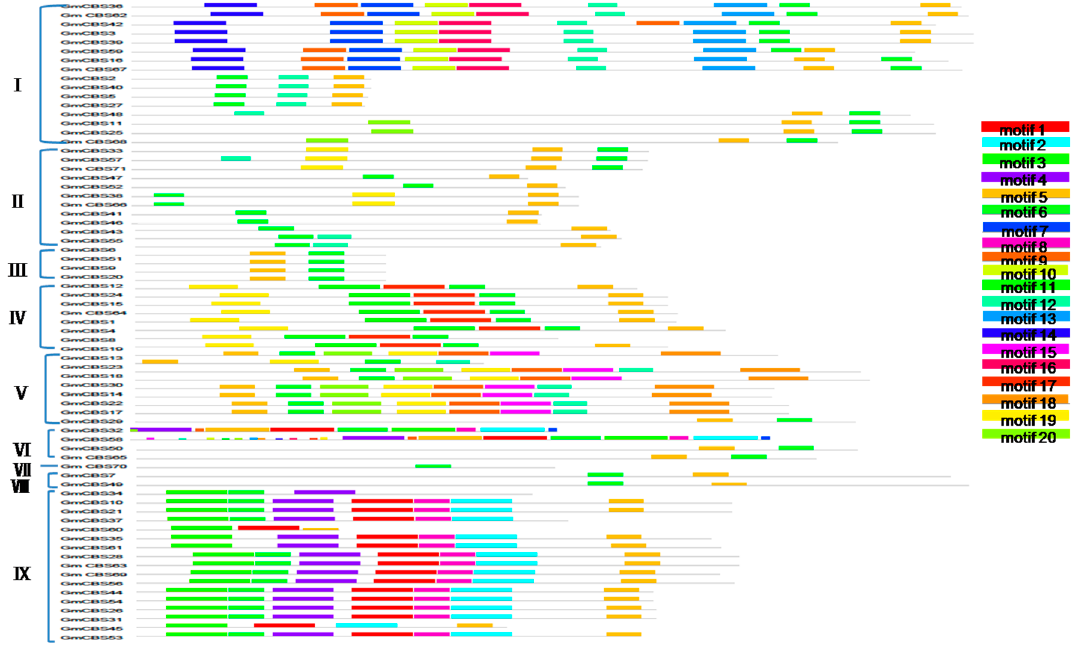
Figure 2. Schematic distribution of the conserved motifs in soybean CBS superfamily by MEME. The conserved motifs were identified in the proteins of every group. Each colored box below the tree represents the conserved motifs. Motif 2, 5, 6, 8, 9, 15 and 19 were CBS-related motifs.